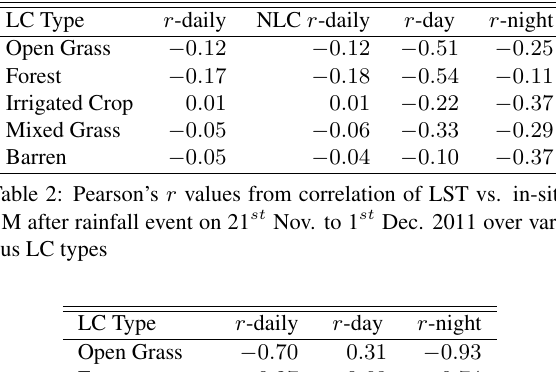
Figure 3: daily rainfall in Birdlings Flat site during Nov. 2011